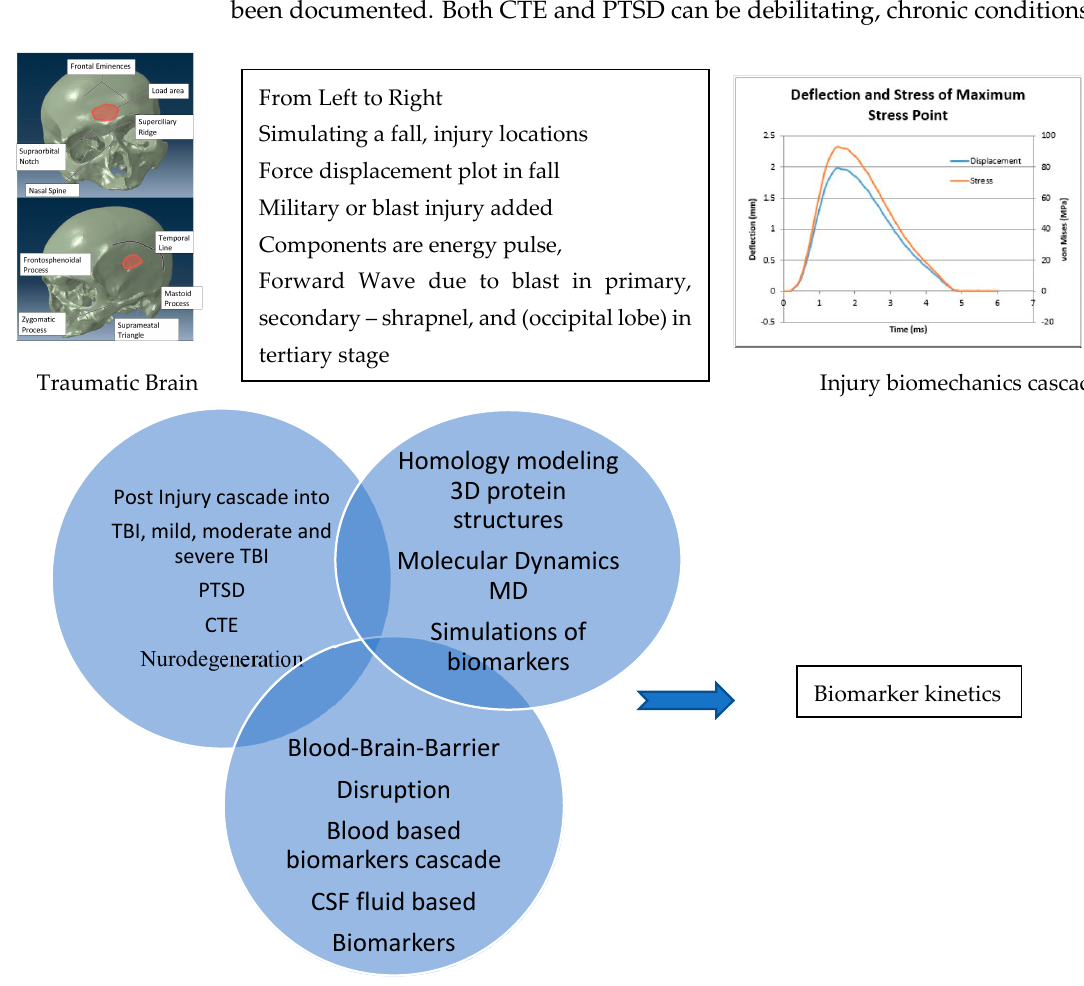
Figure 1. Injury from fall/blast with force, displacement and occipital injury, cascading into TBI, PTSD and CTE, investigated within protein homology, MD, blood–brain barrier and kinetics. The cascade from the onset of injury causing TBI to degenerative conditions, PTSD, has not been fully understood. Figure 1 shows injury locations resulting from fall in con- cussion/mTBI, however, additional components added to simulate a military blast sce- nario involving forward wave propagation and energy, shrapnel and occipital lobe in pri- mary, secondary and tertiary stages, respectively. Post injury cascade is in terms of bi- omarkers, disruption in blood brain barrier, and their kinetics has not been fully under- stood. Therefore, a measurable fluid based TBI biomarker in conjunction with imaging modalities will help diagnosis and prognosis [3]. Additionally, TBI transitioning into PTSD within a year of injury [4] or sequentially resulting in neurodegeneration has been documented. Both CTE and PTSD can be debilitating, chronic conditions [4].